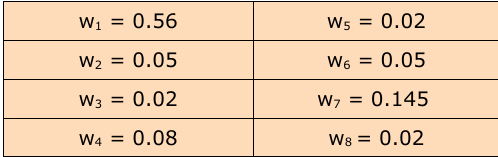
Table 12. normalized defuzzified weights of hazard factors/sub-criteria